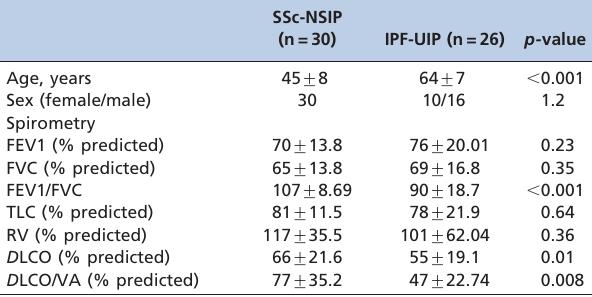
Table 1 - Clinical data of the patients with systemic sclerosis and idiopathic pulmonary